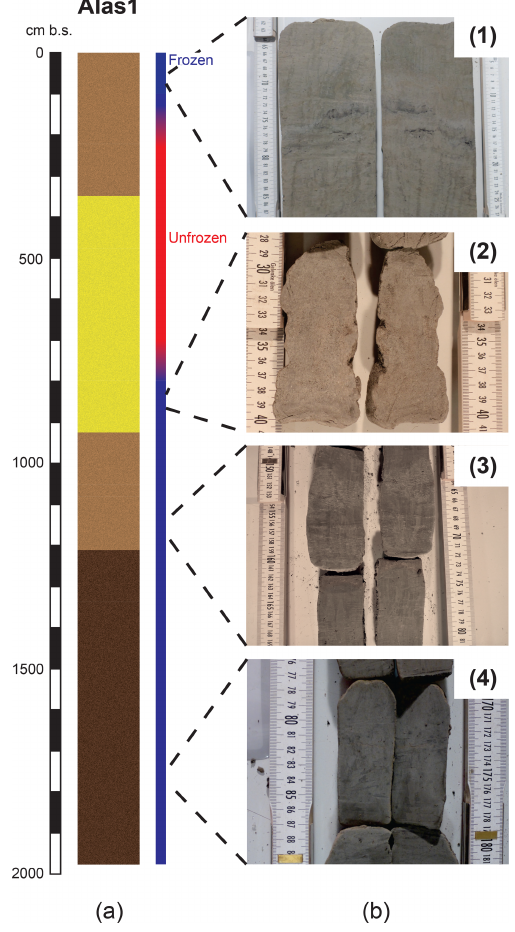
Figure 5. (a) Overview of the Alas1 core. The depth is given in centimeters below the surface (cmb.s.); the state after core retrieval is given using colors (blue – frozen; red – unfrozen); light brown marks silty material, yellow marks sandy material and dark brown marks silty material containing more organic material. (b) Detailed pictures of the Alas1 core: (1) 88–64cmb.s. – picture of A1 show- ing the silty gray matrix including dark organic structures; (2) 840– 828cmb.s. – picture of the sandy A2 unit; (3) 1169–1148cmb.s. – picture of A3 showing a silty gray matrix with some darker or- ganic dots; (4) 1781–1767cmb.s. – picture of the fine-grained silt- dominated A4 unit including black organic-rich